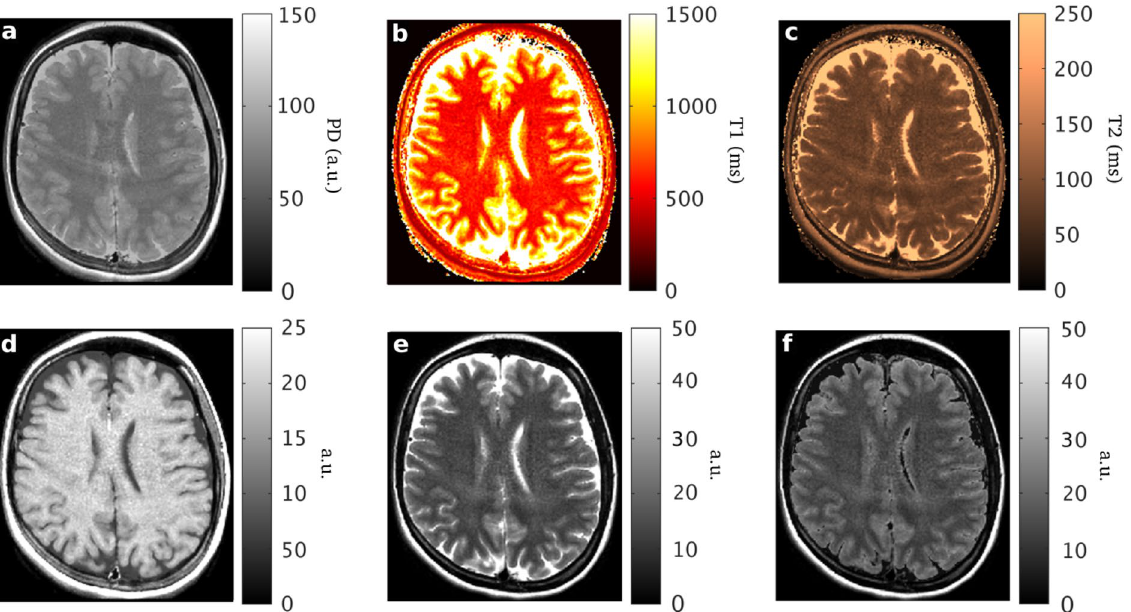
Figure 9. The parametric maps and synthetic images as obtained with MAGIC : (a) PD (proton density, a.u.); (b) T 1 (ms); (c) T 2 (ms); (d) synthetic T 1 -weighted; (e) synthetic T 2 -weighted; (f) synthetic T 2 -FLAIR.